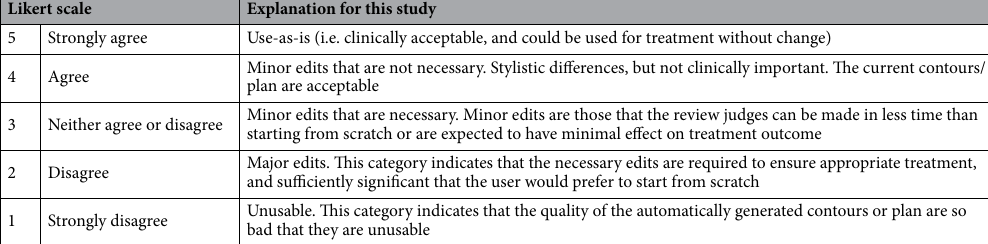
Table 1. Likert scale used by physicians to evaluate contours generated on contrast- enhanced and non- contrast-enhanced CT images.